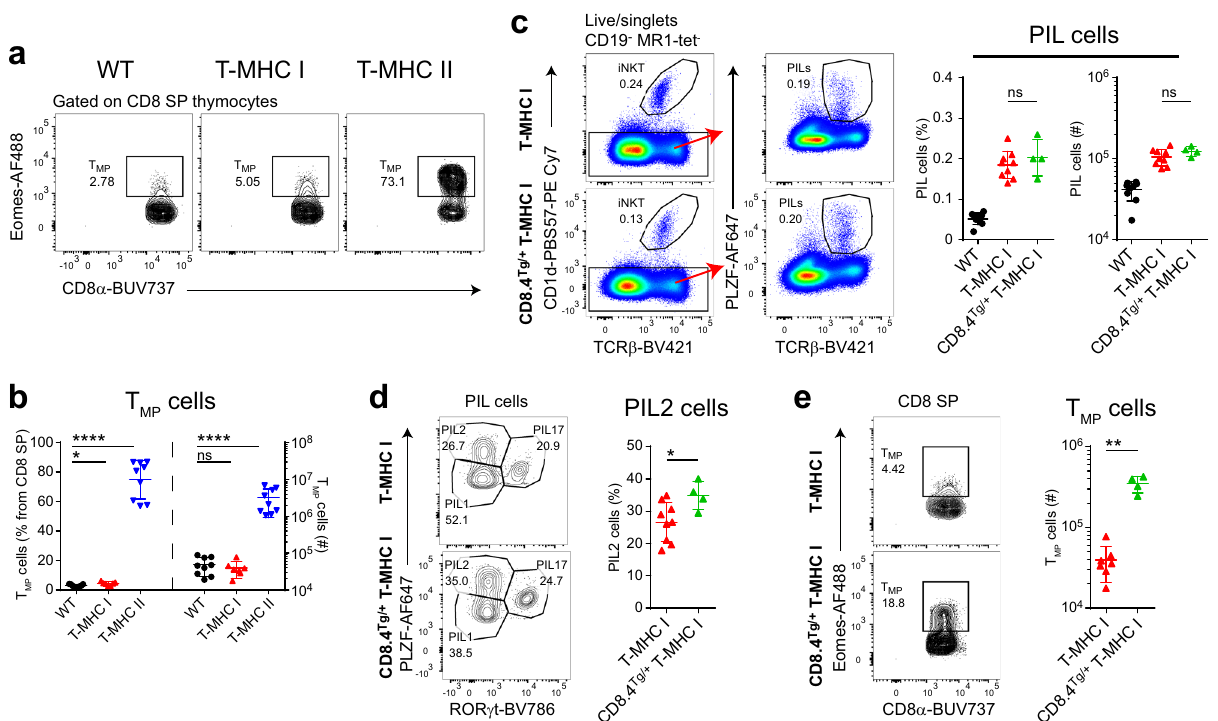
Fig. 5 MHC II, but not MHC I, drives type 2 cytokine production in PIL T cells and induces memory phenotype CD8 T (T MP )-cell development. a Representative fl ow cytometry plots of intracellular staining for Eomes on CD8 SP thymocytes from WT, T-MHC I, and T-MHC II mice. b Number (plotted on the right axis) and frequency (plotted on the left axis) of CD8 T MP cells among CD8 SP cells in the thymus from WT, T-MHC I, and T-MHC II mice, de fi ned by the gating strategy shown in a . c Representative fl ow cytometry plots of thymocytes comparing PIL T-cell frequency from T-MHC I mice with CD8.4 Tg/ + T-MHC I mice. Shown are summary evaluations for PIL T-cell number and frequency (right two panels). d Representative fl ow cytometry plots and summary evaluation for frequency of PIL2 T-cell subset among thymocytes from T-MHC I and CD8.4 Tg/ + T-MHC I mice. Both groups are compared to WT mice. e Exemplarity fl ow cytometry plots of CD8 T MP cell frequency among CD8 SP cells in the thymus from T-MHC I mice with CD8.4 Tg/ + T-MHC I mice (left two panels) and summary evaluation of CD8 T MP cell number (right panel). Each point represents one animal: n = 9 animals per group (WT and T-MHC II groups) in a , b , n = 9 animals (T-MHC I group) in c , d , n = 7 animals (T-MHC I group) in b , e , and n = 4 animals (CD8.4 Tg/ + T-MHC I group) in c – e . Data are representative of 7 in a , b and 2 in c – e independent experiments. Unpaired two-tailed Mann – Whitney test was performed in b – e ; ns,